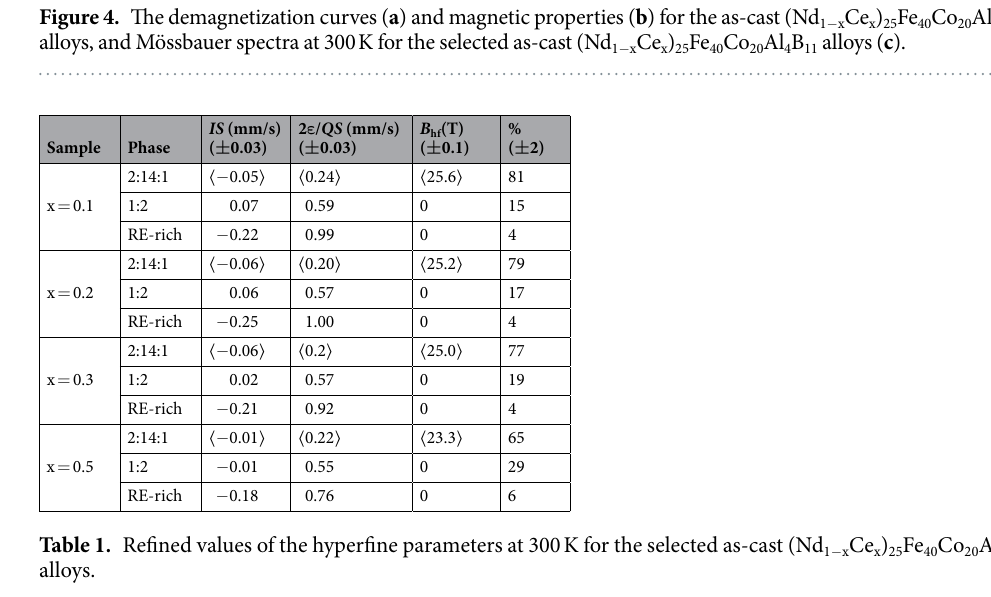
Table 1. Refined values of the hyperfine parameters at 300 K for the selected as-cast (Nd 1 − x Ce x ) 25 Fe 40 Co 20 Al 4 B 11